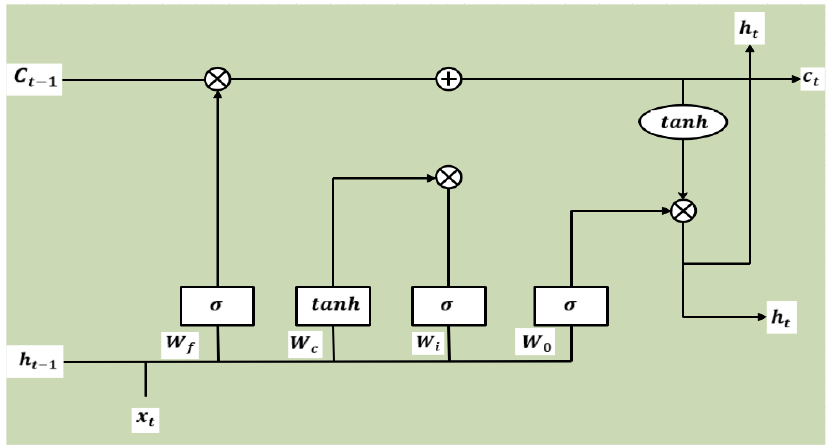
Figure 10. LSTM unit for remote sensing scene classification.